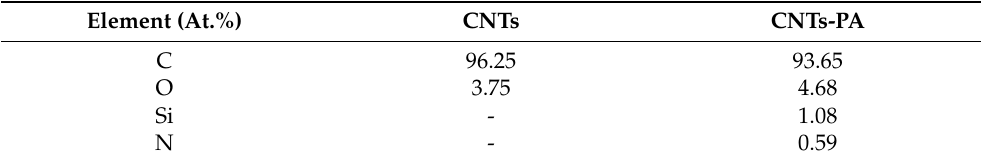
Figure 3 . XPS survey spectra of CNTs and CNTs ‐ PA. Table 1 . Element composition of CNTs and CNTs ‐ PA. Table 1. Element composition of CNTs and CNTs-PA.